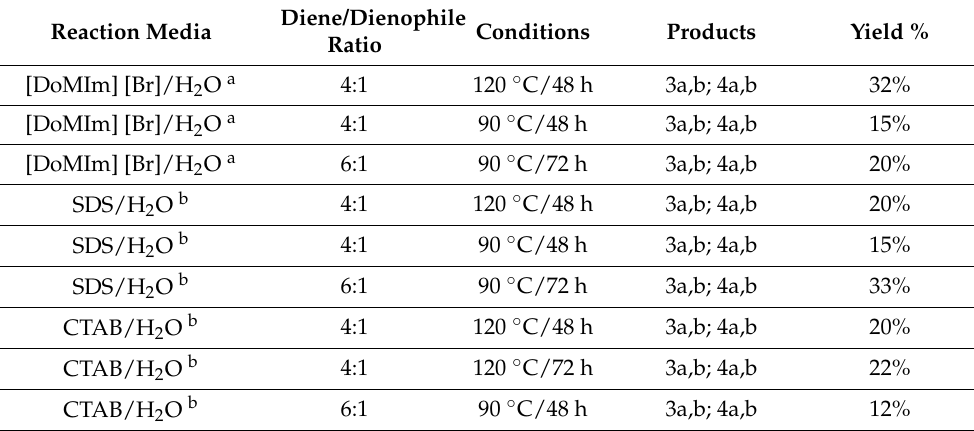
Table 1. Comparison of DA reaction in different aqueous micellar